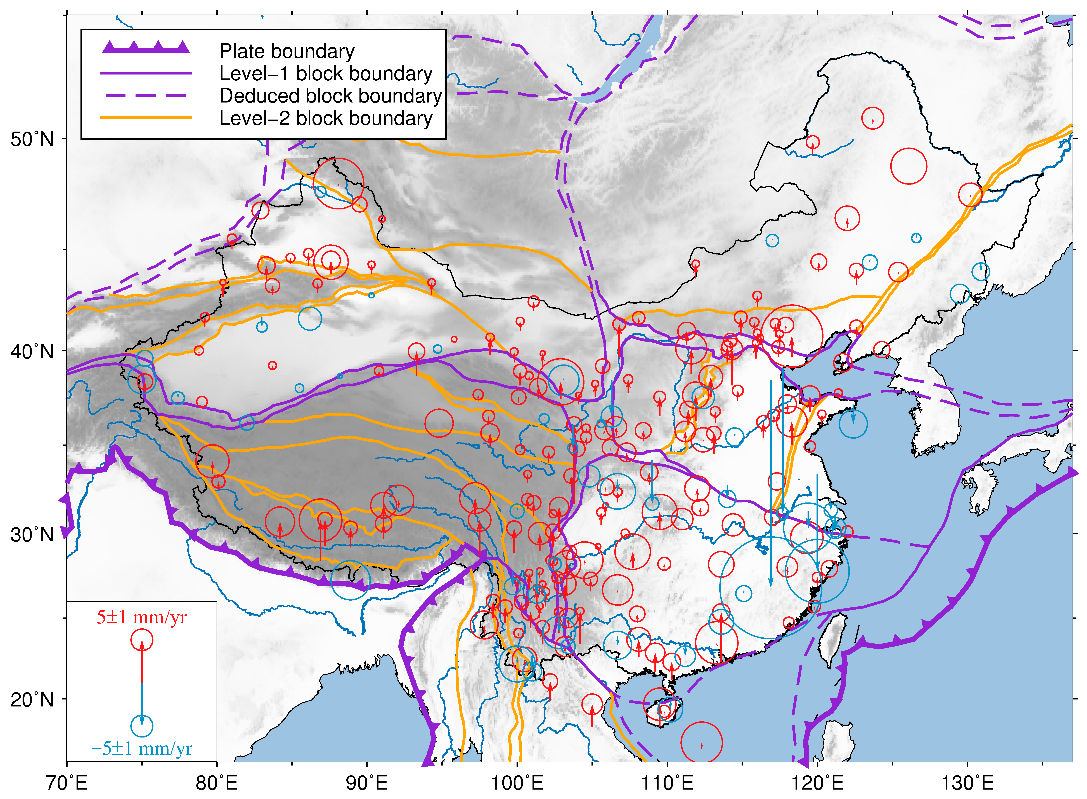
Figure 15. Same as Figure 14, but for the vertical velocity field.